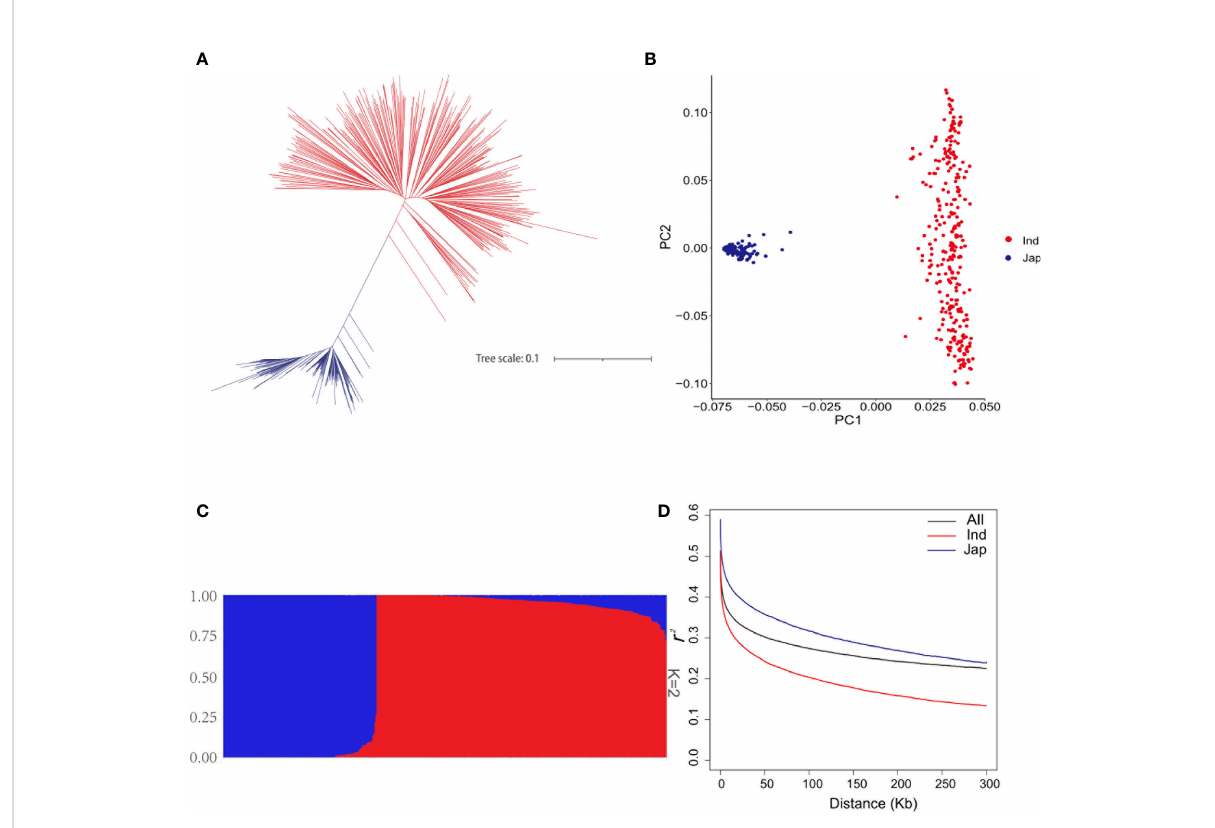
FIGURE 2 Population analyses of the genetic panel. (A) Phylogenetic tree of 448 rice accessions. (B) Principal component analysis of 448 rice accessions. (C) Population structure estimated by ADMIXTURE. (D) LD decay analysis of the genetic panel; LD decay of all 448 rice accessions, indica accessions, and japonica accessions is indicated in black, red, and blue,